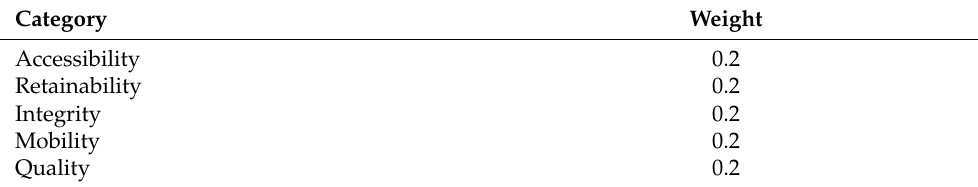
Table 2. Equal weight method.